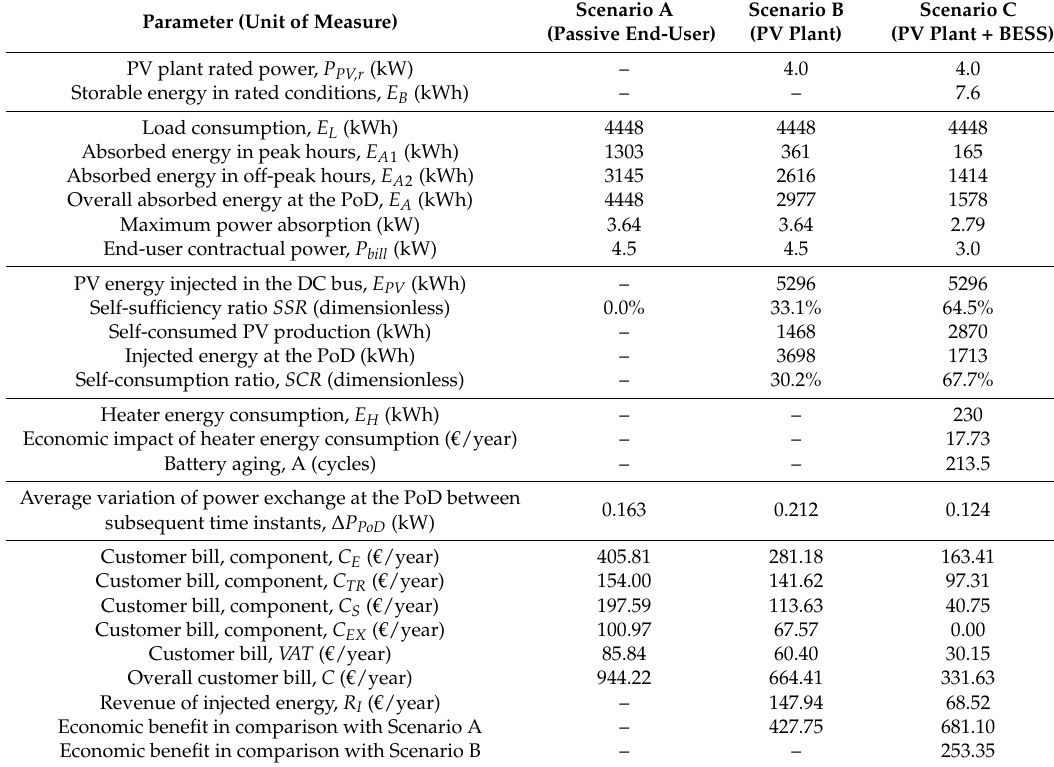
Table 7. Main results obtained by adopting the developed simplified thermoelectric model of the sodium-nickel chloride BESS to a real case residential prosumer, in the considered scenarios (annual